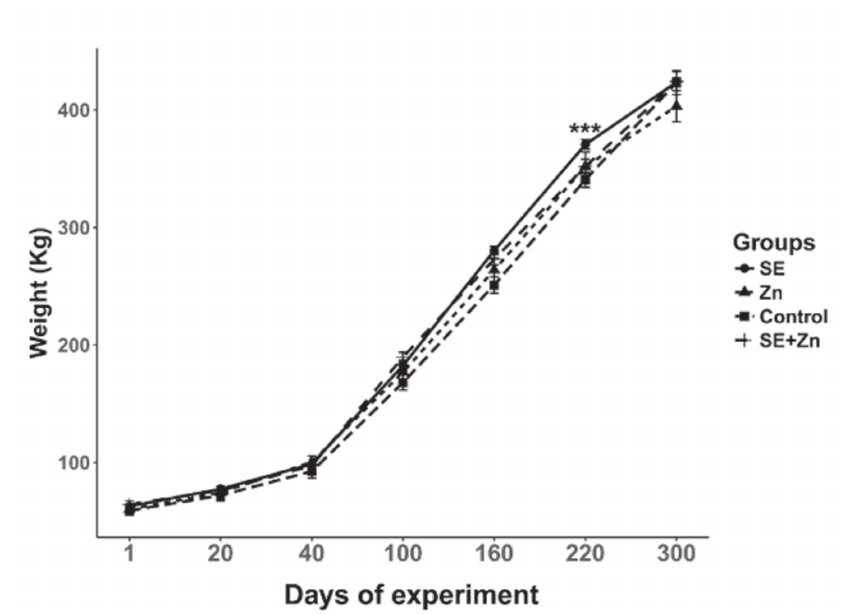
Figure 1 - Distribution by group of weigh in newborn calves. each day of sampling the mean and standard deviation of each variable are been represented. *** P < 0.001 and represents significant differences between groups. Note: day 1 of experiment correspond at day 50 of